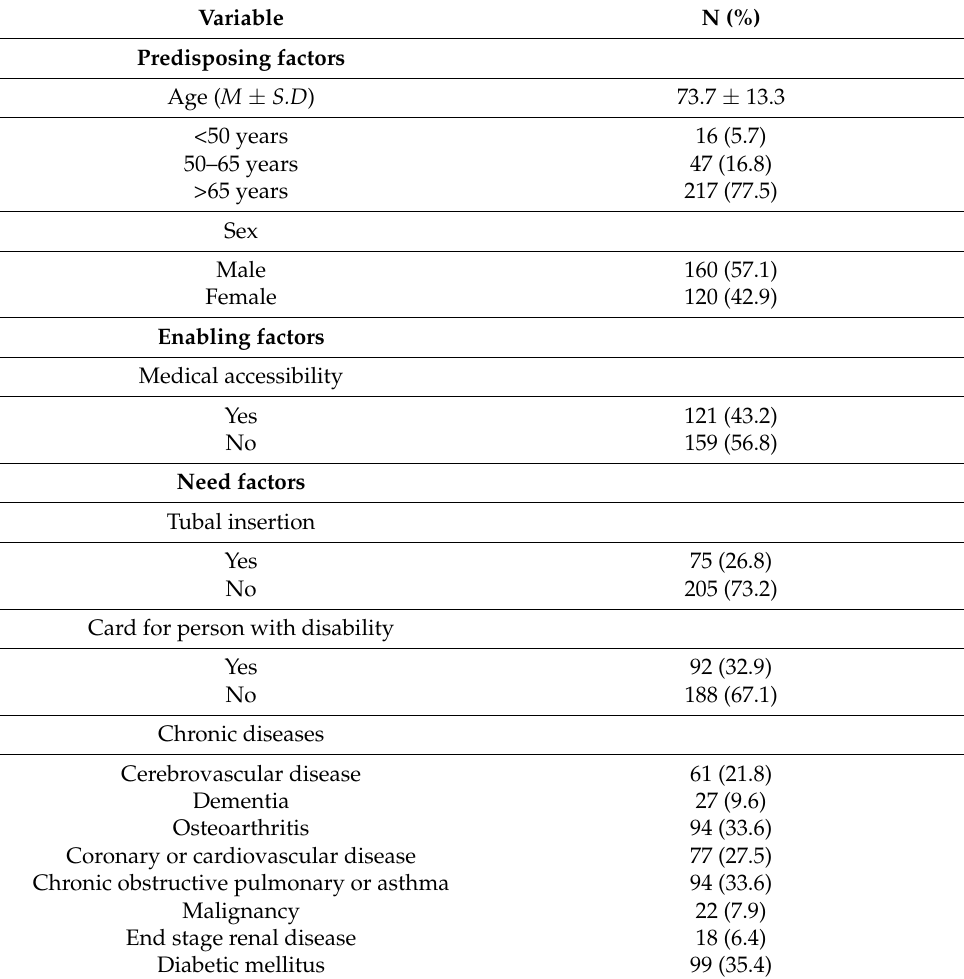
Table 1. Characteristics of patients using service of discharge planning (N =